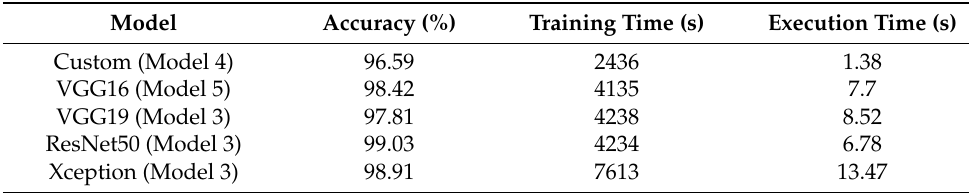
Table 5. Performance of the compared model.